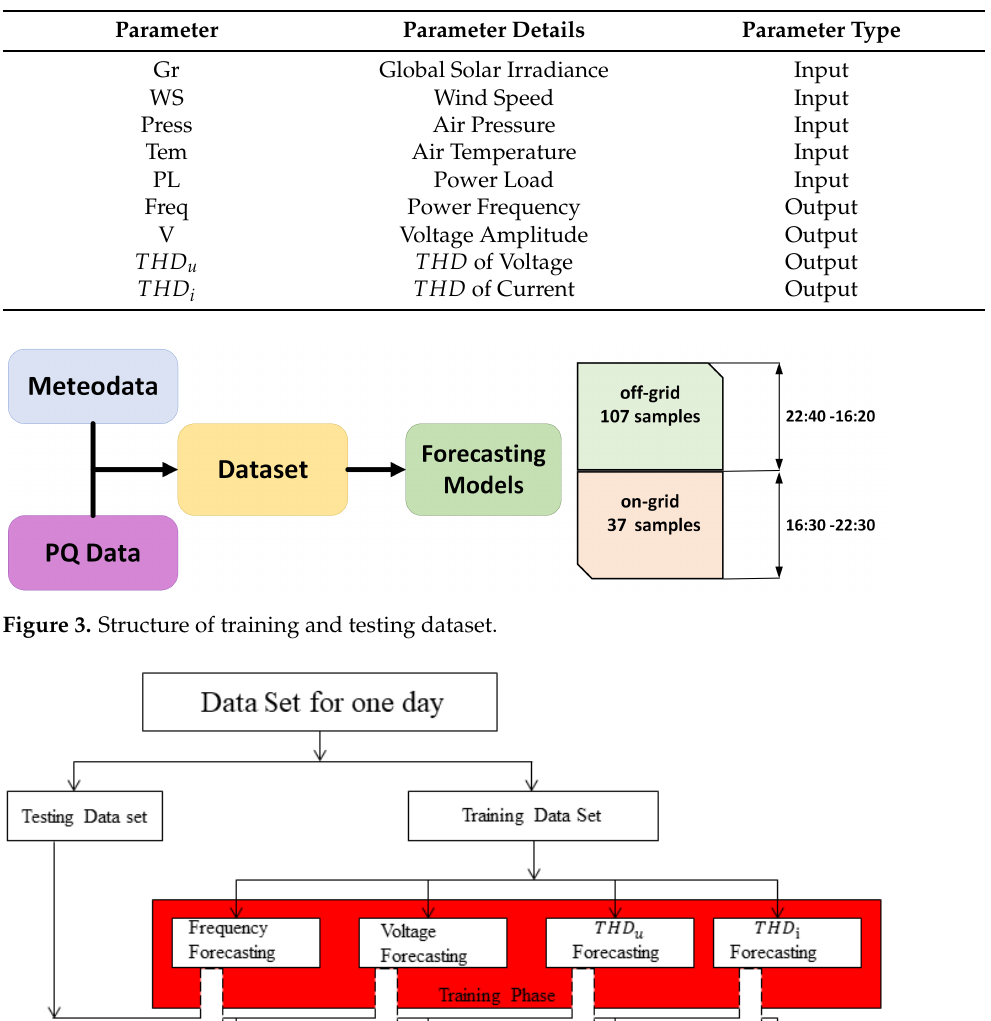
Figure 2. Scheme of the designed model. The input variables are solar irradiance (SI), wind speed (WS), air pressure (PR), air temperature (TEM), and power load (PL). The output are frequency, voltage, THD u , and THD i . Table 3. Input and output variables.